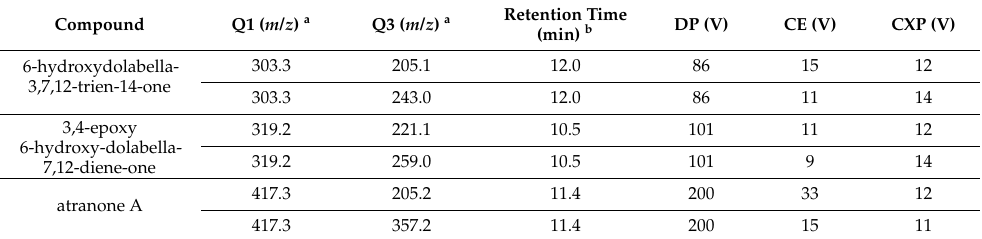
Table 1. MRM-transitions and substance-specific parameters for the identification of 6-hydroxydolabella, 3,4-epoxy 6-hydroxydolabella, and atranone A by LC-MS/MS. Compound